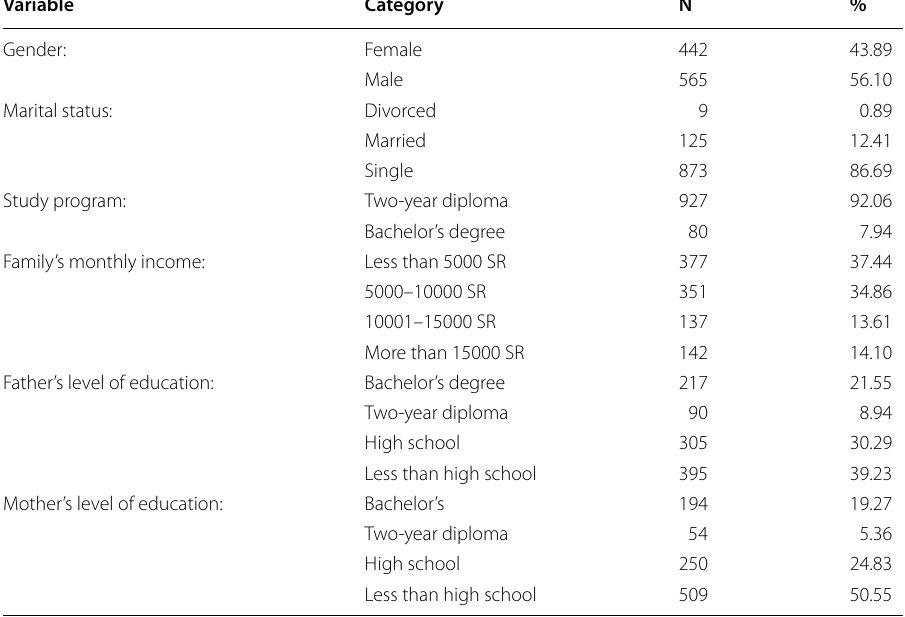
Table 3 Socio-demographic statistics